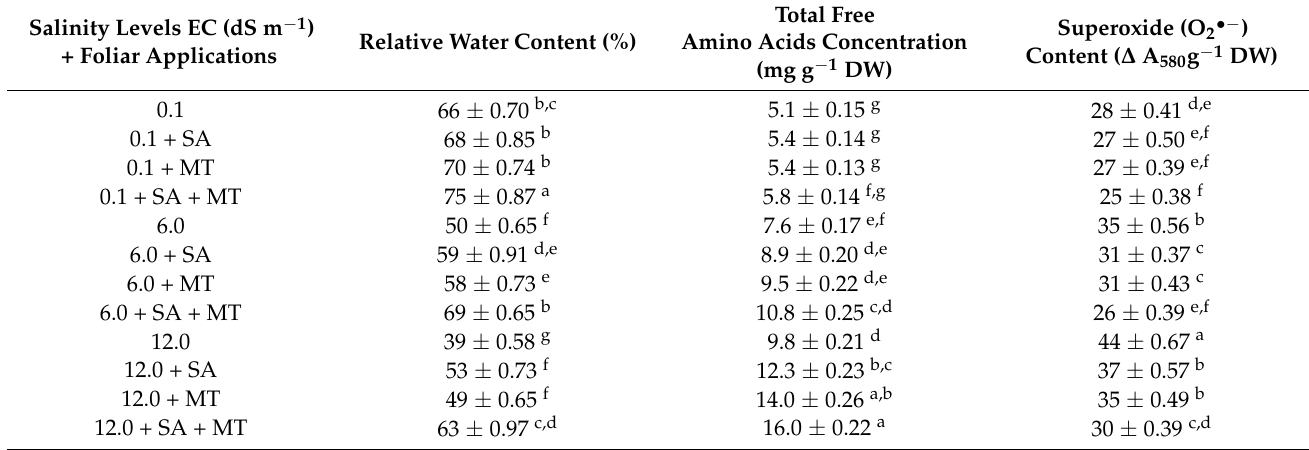
Table 2. Influence of salicylic acid (SA, 75 mg L − 1 ), melatonin (MT, 70 µ M), and SA (75 mg L − 1 ) + MT (70 µ M) foliar application treatments on the relative water content (%),total free amino acids concentration, and superoxide (O 2 •− ) content levels in leaves of wheat plants grown under 0.1, 6, and 12 dS m − 1 salinity